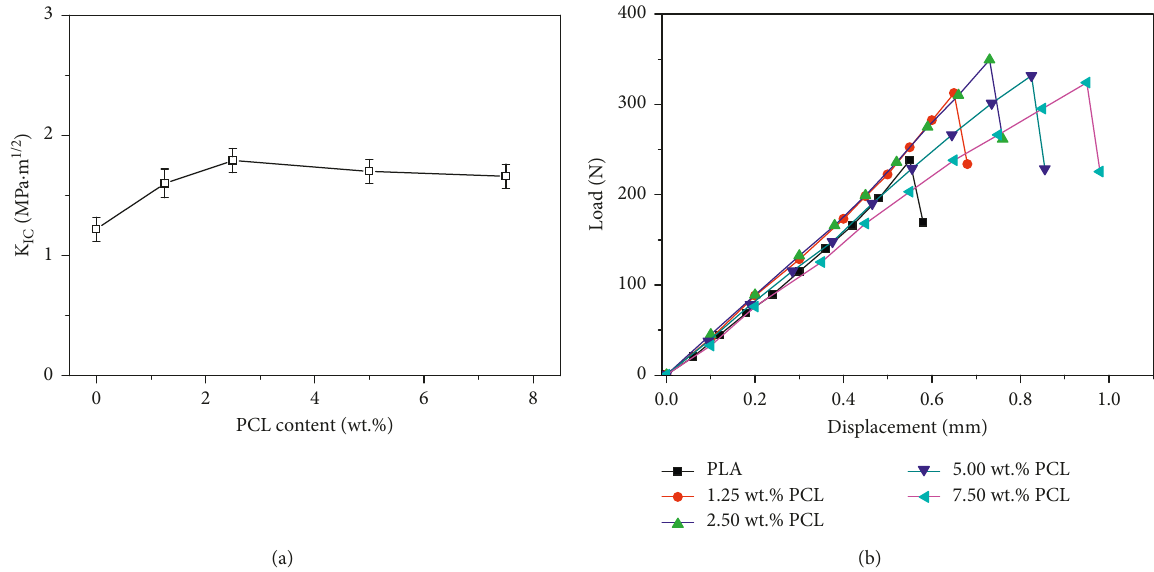
Figure 5: Fracture toughness of PLA/PCL blends as a function of PCL content.